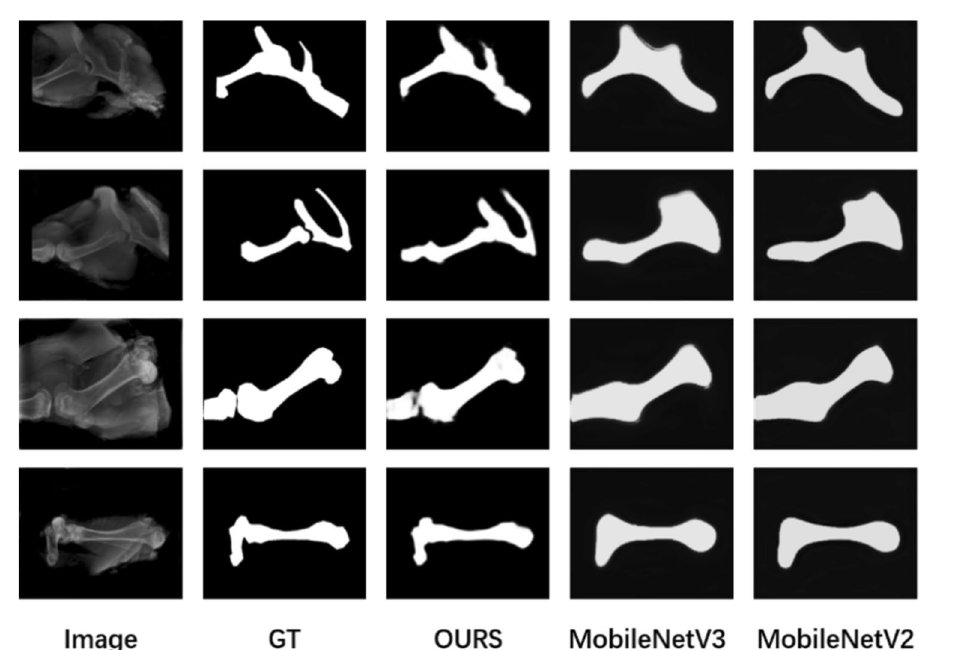
Figure 7. Qualitative comparison of the proposed method with a generic lightweight method on X-ray